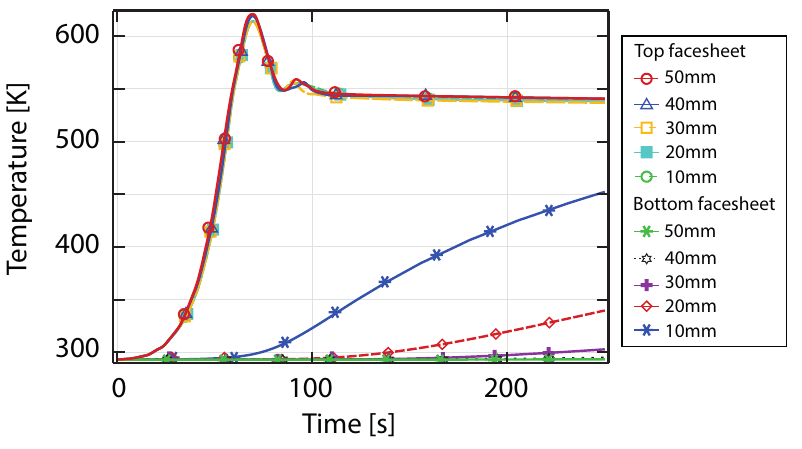
Figure 14. Top and bottom face sheet temperature evolution for different thicknesses of the insulation layer ( t c ins